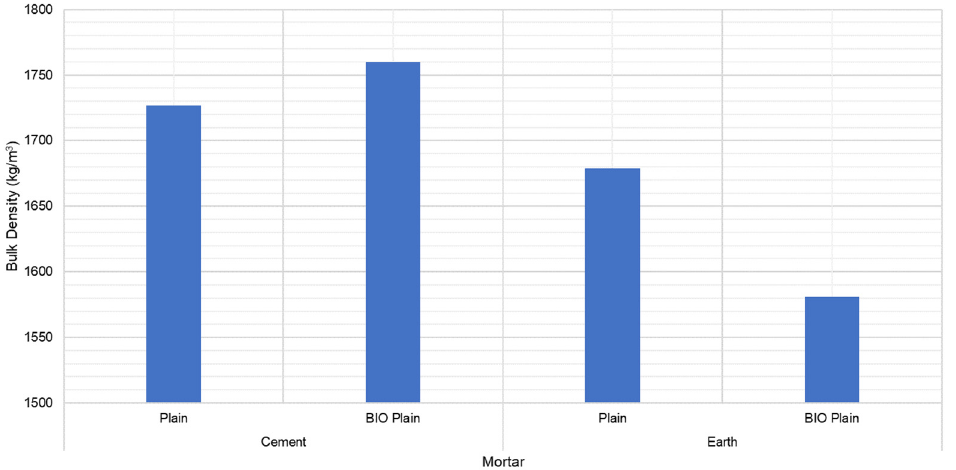
Figure 4. Bulk density for the cement- and earth-based mortars (plain) with and without biostabiliser (bio). Coefficient of variation (CoV) per family of mortar: cement mortar: 1.0%; cem+bio: 0.5%; earth mortar: 4.8%; earth+bio: 1.0%.